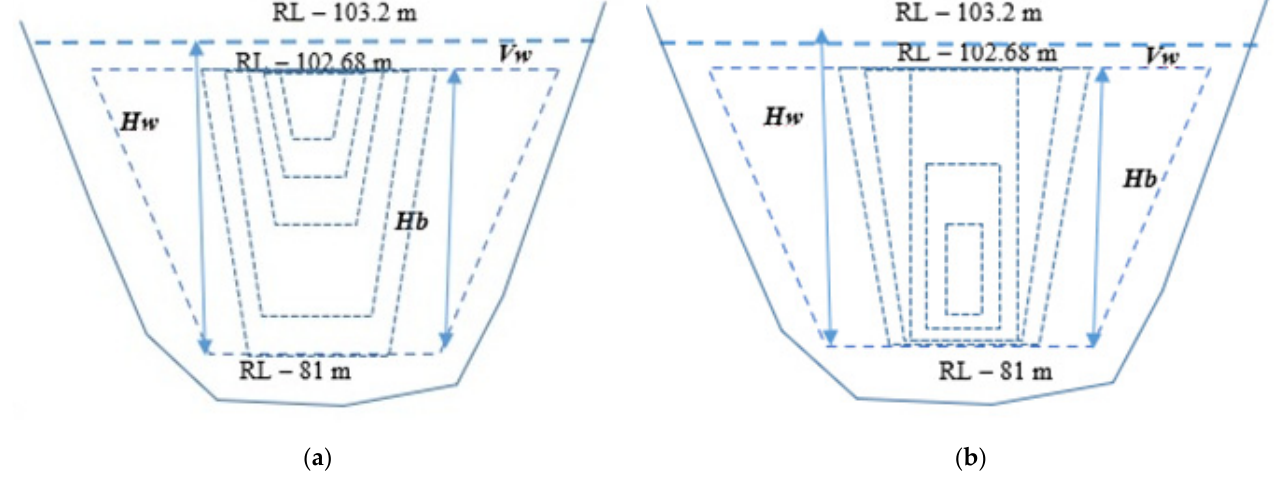
Figure 8. Spillway breach by ( a ) Scenario 1: overtopping and ( b ) Scenario 2: piping.